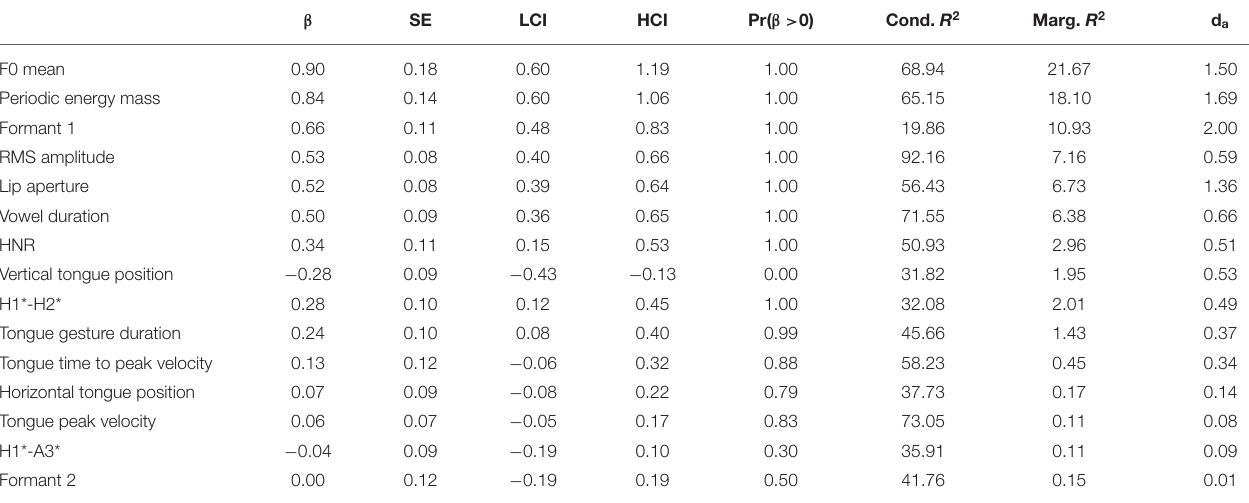
TABLE 2 | Tabular overview of modeling results for unaccented vs. accented, vowel /a/. LCI and HCI refer to the low and high boundaries of the 90% Credible